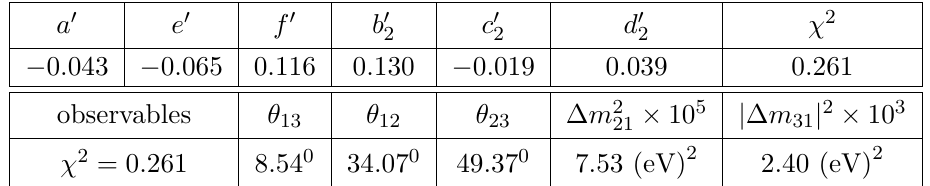
Figure 8 . The plot on the left hand side shows the range of the wash-out parameters. The red dot corresponds to the minimum value of (cid:31) 2 for which a set of primed parameter has been taken to compute Y B . The plot on the right hand side shows (cid:12)nal Y B for di(cid:11)erent values of M 1 for the inverted light neutrino mass ordering.